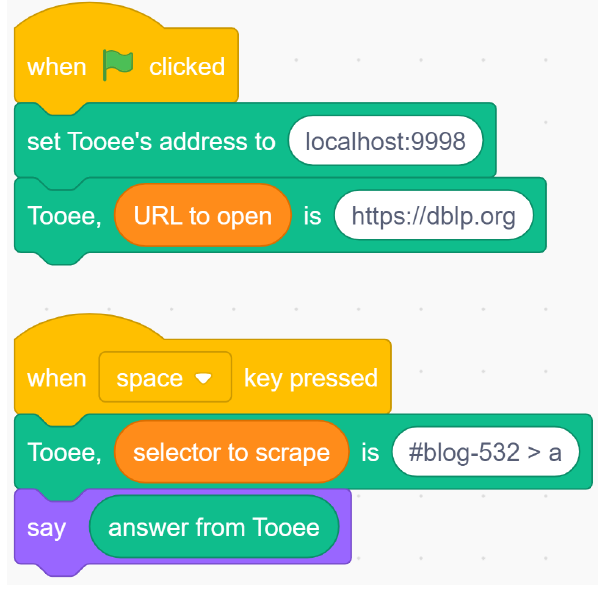
Figure 3. An example Scratch code for scraping a DBLP web page. When the green flag is clicked, the Scratch client connects to the WebSocket server and opens the https://dblp.org web page. When the space key is pressed, the content of the HTML element corresponding to the CSS selector “#blog- 532 > a” is